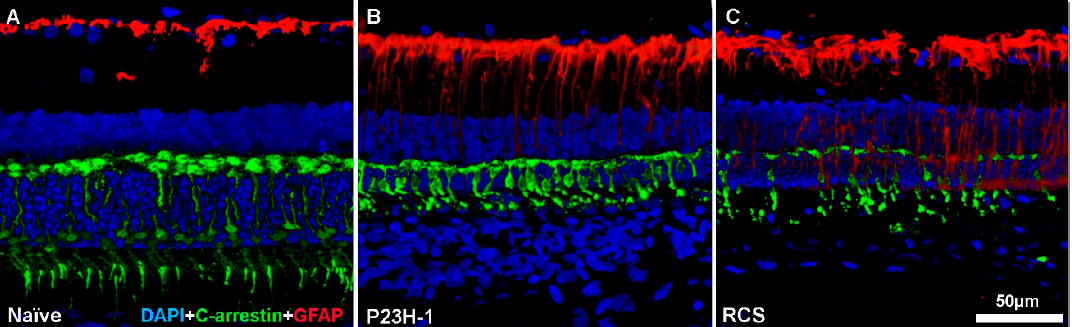
Figure 2. Cone degeneration and macroglial cell response. Microphotographs of representative retinal cross sections from a naïve SD rat ( A ) showing a normal retina, a retina from a P23H-1 rat ( B ) and a retina from an RCS rat ( C ) in the early stages of retinal degeneration. Cone outer segments appear in green and macroglial cells (GFAP) in red. In both P23H-1 rats and RCS rats, cones degenerate and lose their typically elongated morphology. Moreover, GFAP overexpression in astrocyte and Müller cells could be seen.